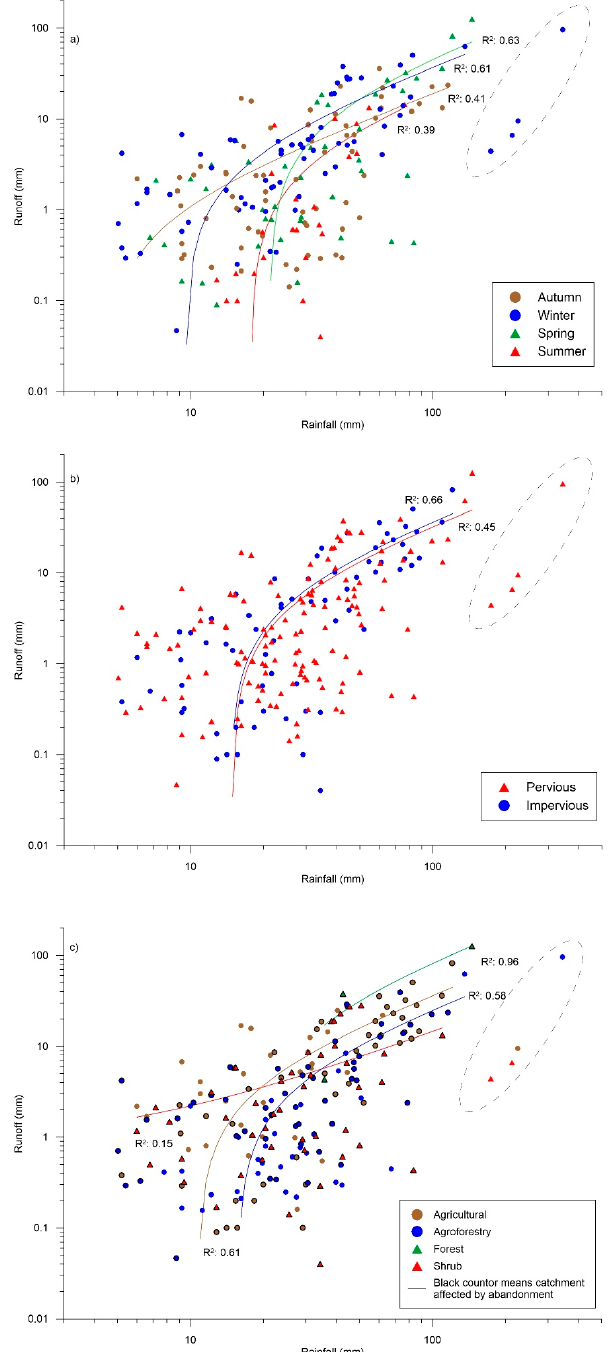
Figure 3. Rainfall-runoff relationship at the event scale classified by ( a ) season, ( b ) lithology and ( c ) land uses at 12 small Mediterranean-climate catchments. Outliers are marked with an ellipsoid.